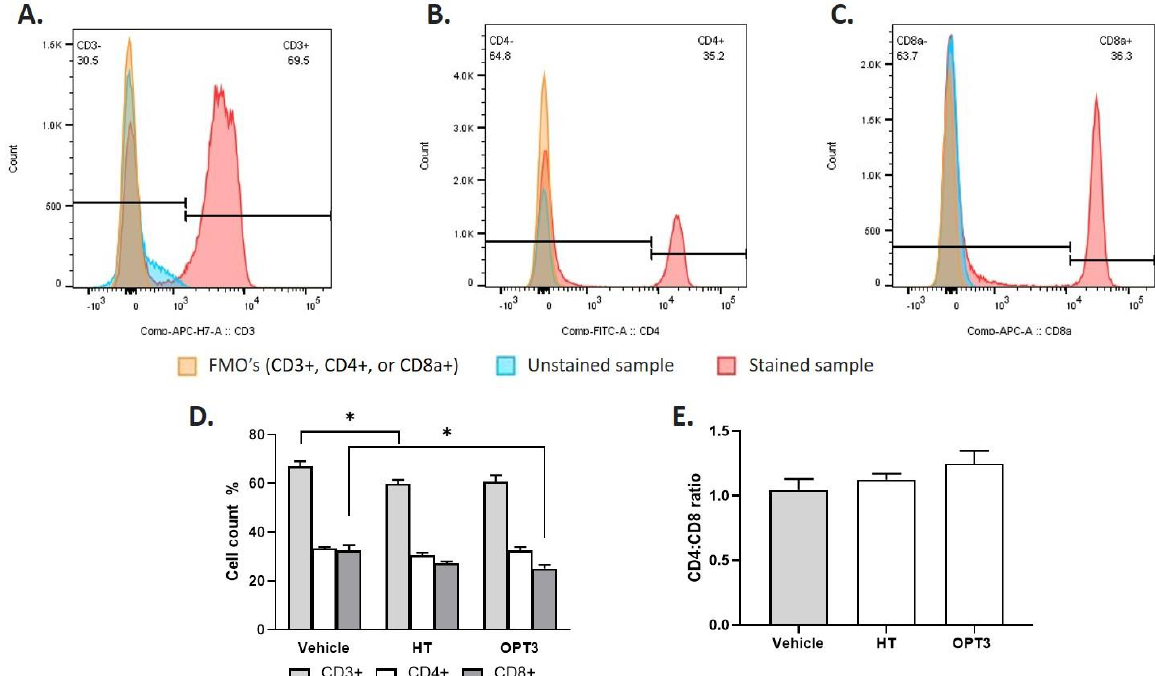
Figure 4. FACS analysis of CD3+, CD4+, and CD8+ T cells of draining lymph nodes of mice exposed to DS for 14 days and received topical treatment of a selected crude OP extract (OPT3) (0.20 mg/mL) and HT (100 μM/0.015 mg/mL). ( A ) Representative FACS histograms for CD3+, ( B ) representative FACS histograms for CD4+, ( C ) Representative FACS histograms for CD8+, ( D ) Percentages of CD3+, CD4+, and CD8+ T cells in terms of total live cells. HT significantly decreased the total number of CD3+, and OPT3 the total number of CD8+, compared with control (vehicle-treated mice). ( E ) Calculated CD4:CD8 ratio. * p -value < 0.05.